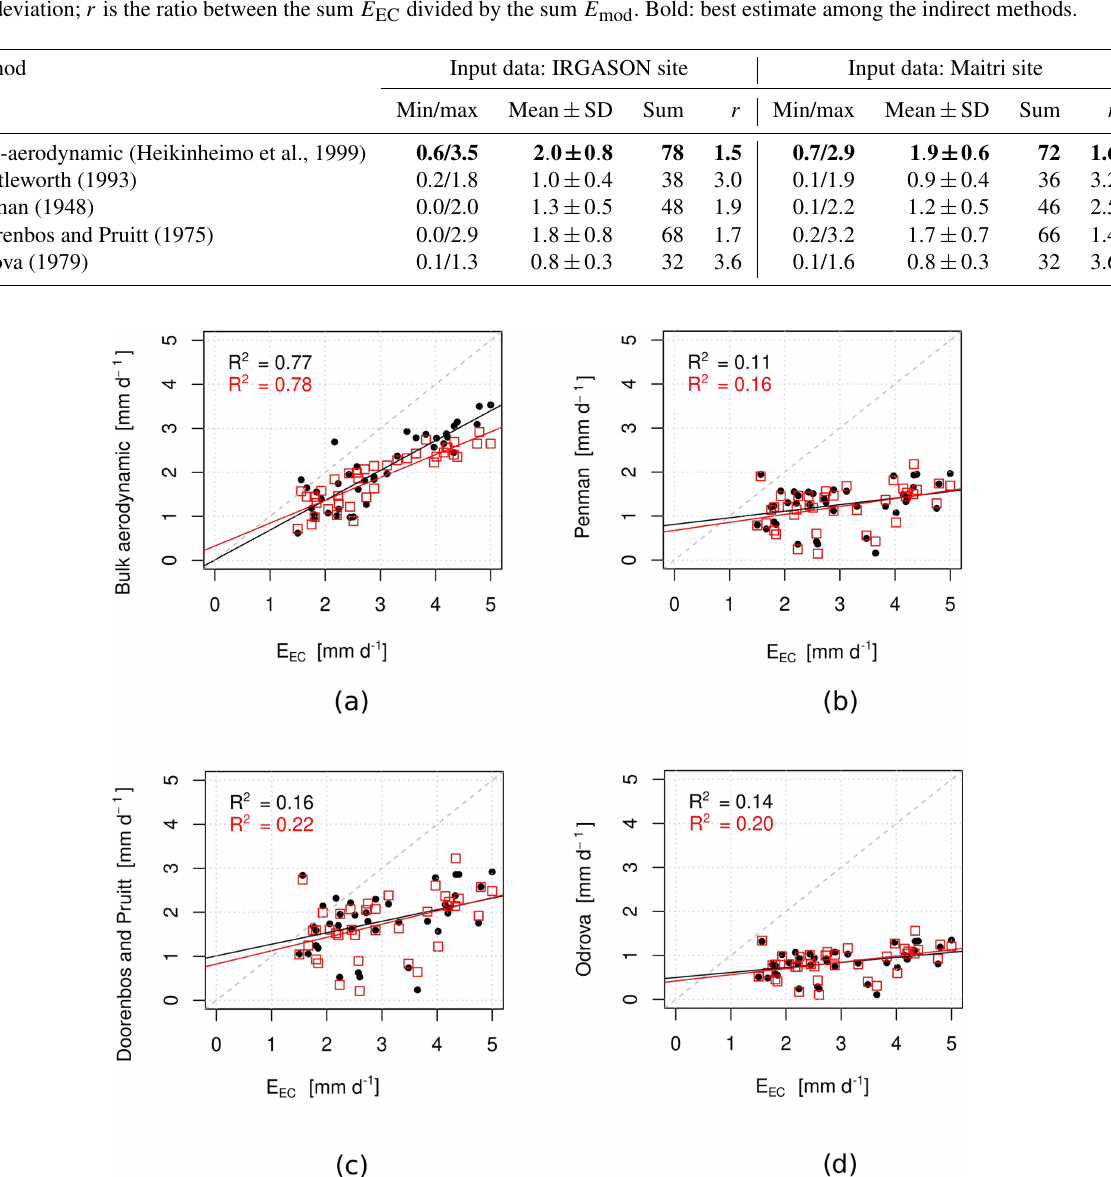
Figure 6. Scatter plots of the daily evaporation estimated with the indirect methods ( y axis) against the direct EC method ( x axis): (a) the bulk-aerodynamic method, (b) Penman (1948), (c) Doorenbos and Pruitt (1975), and (d) Odrova (1979). R 2 refers to the determination coefficient. The red dots indicate the estimates of the evaporation with the meteorological parameters measured at the WMO synoptic site Maitri, which is the nearest site to Lake Zub/Priyadarshini. The black dots indicate the estimates of the evaporation made with the meteorological parameters measured at the lake shore (IRGASON